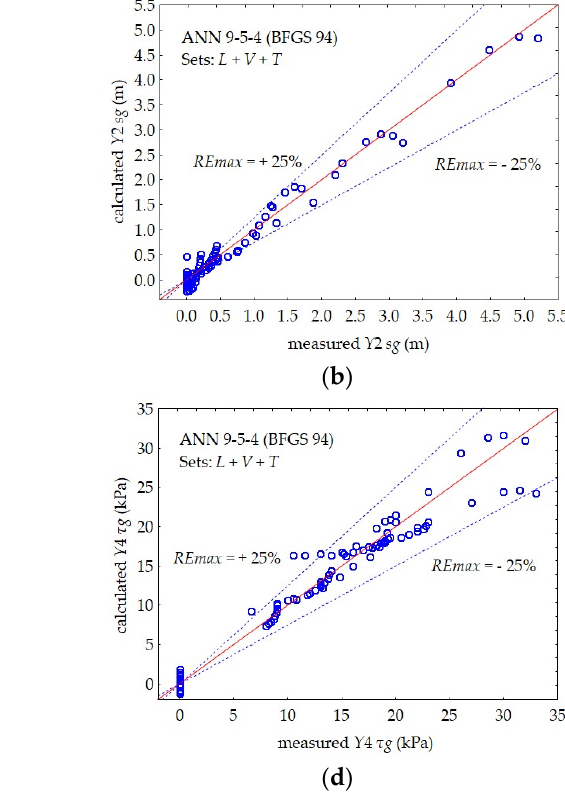
Figure 10. Comparison between the measured and calculated values by ANN 9–5–4 in subsets L + V + T : ( a ) Y 1 sp , ( b ) Y 2 sg , ( c ) Y 3 τ p , and ( d ) Y 4 τ g .